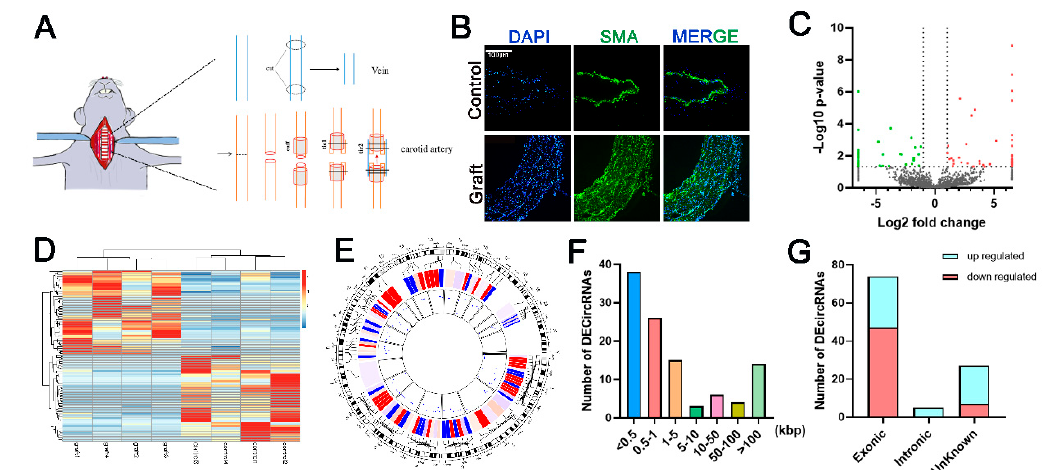
Figure 1. Characterization of differentially expressed circular RNA. ( A ). Schema of the rat vein graft model using “cuff” technique. One week after surgery, graft vein and the right jugular vein were harvested for the subsequent experiments, n = 4. ( B ). Immunofluorescent staining shows that the vascular wall of graft vein is thicker than those in the control group. 4 ′ ,6-diamidino-2-phenylindole (DAPI) stains the nucleus blue, and green represents vascular smooth muscle cells (VSMC)-specific marker smooth muscle α -actin. Bar = 100 µ m. ( C ). Volcano map of circular RNA (circRNA) expression. Two vertical dotted lines correspond to the fold change of ± 2.0. The horizontal dotted line represents that p = 0.05. The red dots and green dots indicate the significantly increased and decreased circRNAs in the graft vein, respectively. ( D ). Heat map shows 106 DE circRNAs. DE CircRNAs are clustered by https://biit.cs.ut.ee/clustvis/ (accessed on 7 September 2020). ( E ). Circlize represents the distribution of DE circRNAs on rat chromosomes. The red lines present upregulated and the blue lines are downregulated circRNAs. ( F ). DE circRNAs length distribution. ( G ). DE circRNAs category distribution.